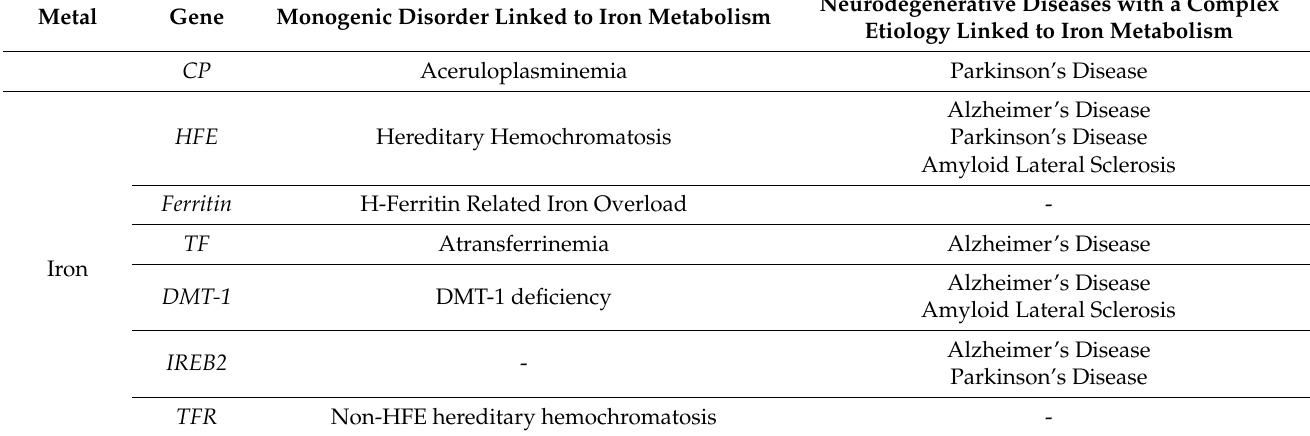
Table 3. Shared traits of inherited metal-metabolic diseases and neurodegenerative